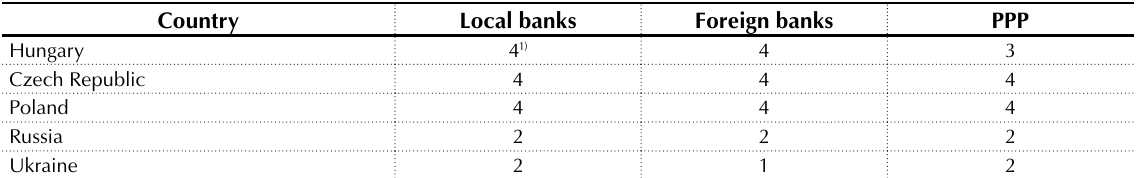
Table 1. Rating of availability of funding from different sources in some countries in